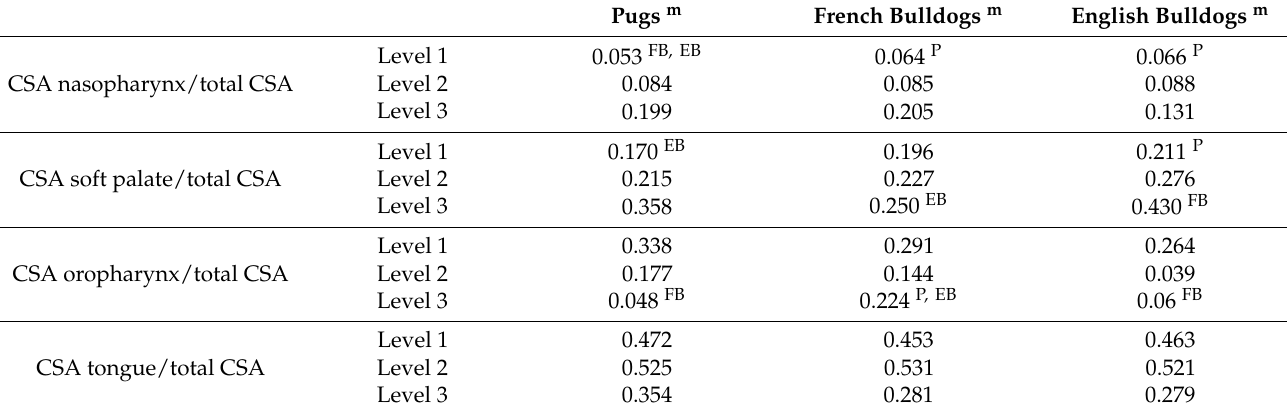
Table 4. Cross sectional area of the nasopharynx, soft palate, oropharynx, and tongue normalized to total CSA.